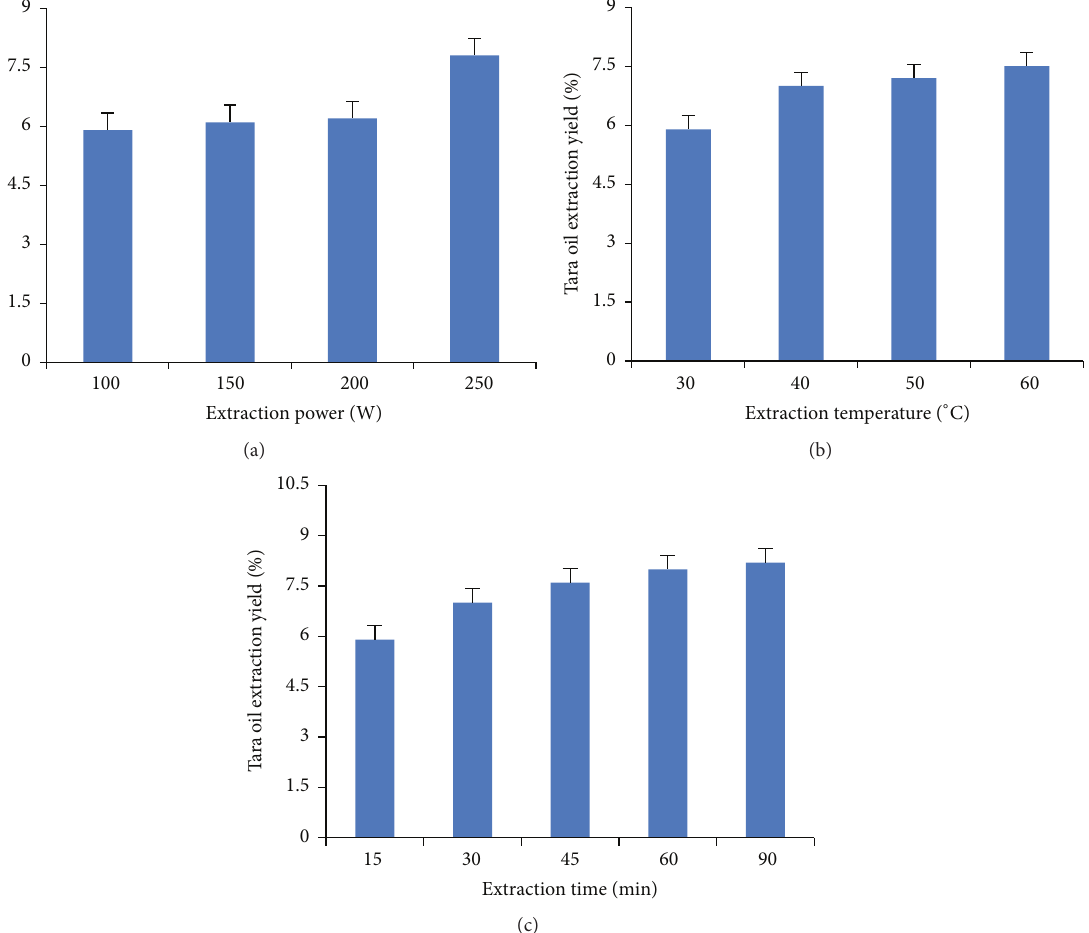
Figure 3: (a) Tara seed oil yields with different extraction times. Dry tara seed powder (10g, 60–80 mesh) was extracted for 15, 30, 45, 60, or 90 min. Ultrasonic extraction was performed at 250 W and 30 ∘ C. (b) Tara seed oil yields with different ultrasonication powers. Dry tara powder (10g, 60–80 mesh) was extracted using four different ultrasonication power settings (100, 150, 200, and 250 W). Ultrasonic extraction was performed for 45min at 30 ∘ C. (c) Tara seed oil yields with different ultrasonic extraction temperatures. Dry tara powder (10g, 60–80 mesh) was extracted ultrasonically at 30 ∘ C, 40 ∘ C, 50 ∘ C, or 60 ∘ C. Ultrasonic extraction was performed at 250 W for 45